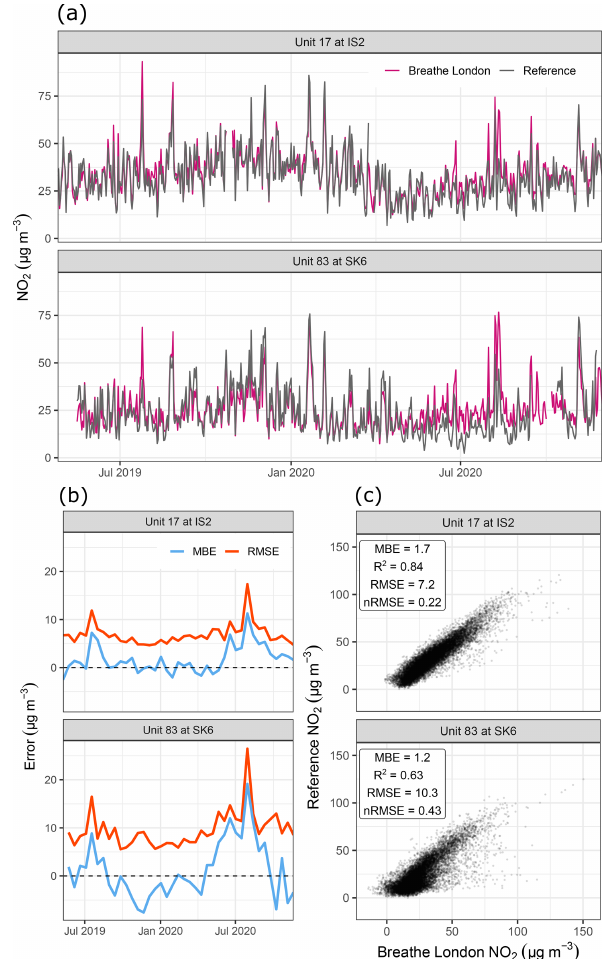
Figure 3. Performance of two calibrated sensors during long-term reference collocations. Sensors were calibrated using linear regres- sion against the reference instrument during a 2-week colloca- tion directly preceding the evaluation period (calibration period not shown). (a) Daily mean NO 2 concentration time series compari- son of BL sensor and reference monitor measurements. (b) MBE (Eq. 1) and RMSE (Eq. 2) statistics of hourly BL sensor measure- ments compared to reference measurements during 14d periods. (c) Scatterplot and statistics (Eqs. 1–4) comparing hourly BL sensor ( x axis) and reference monitor ( y axis) measurements for entire evalu- ation